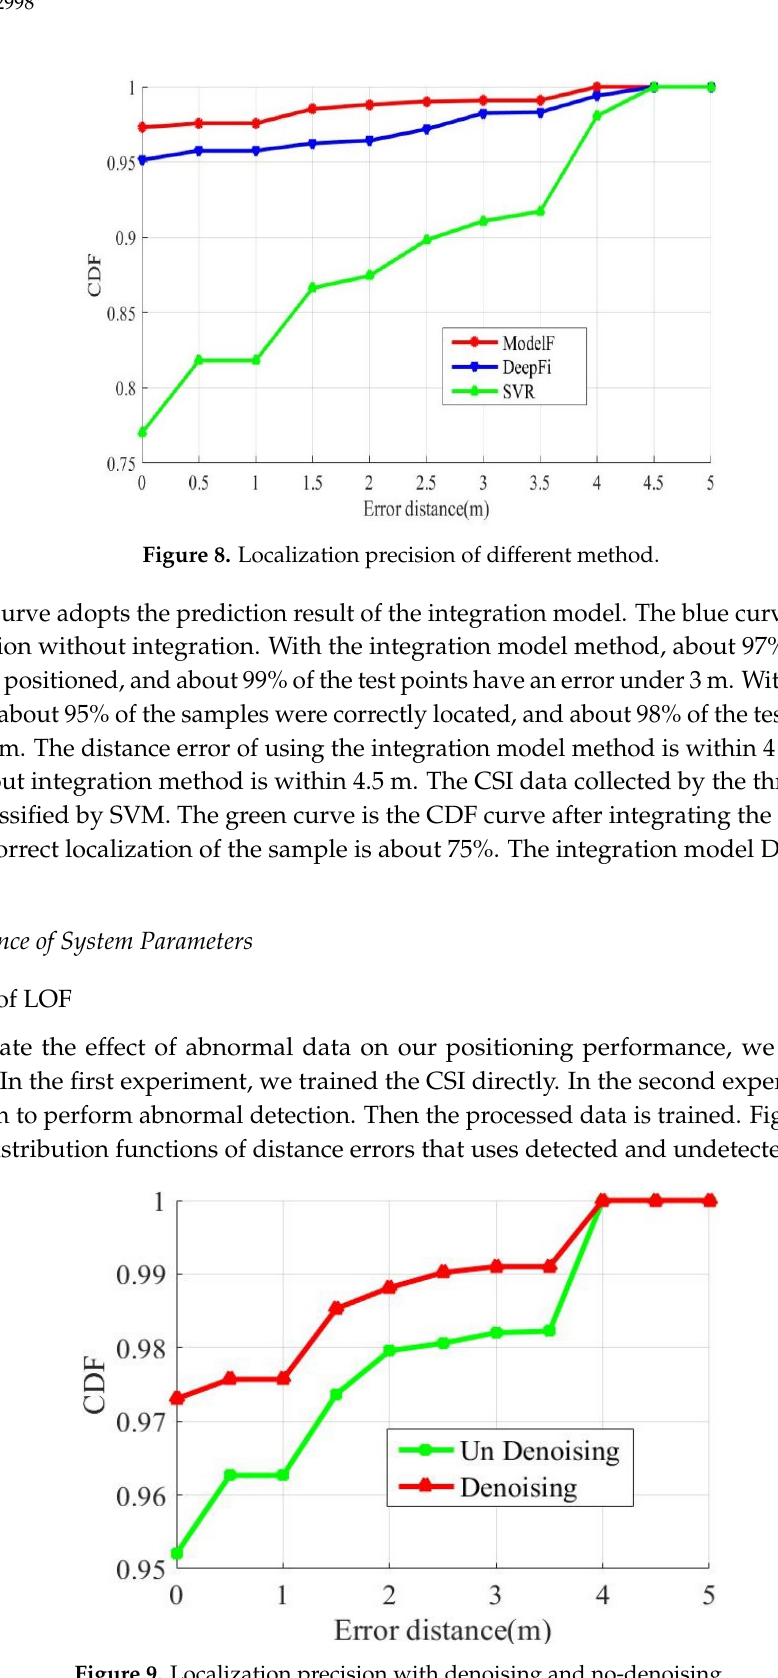
Figure 9. Localization precision with denoising and